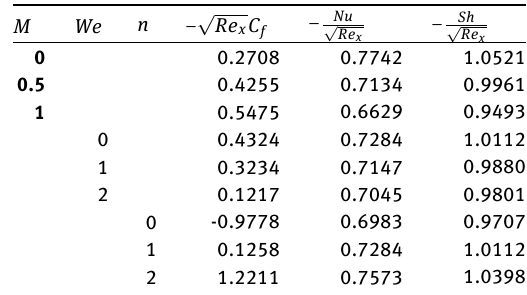
Table 3: Variation of skin friction coefficient, Nusselt number and Sherwood number for different physical